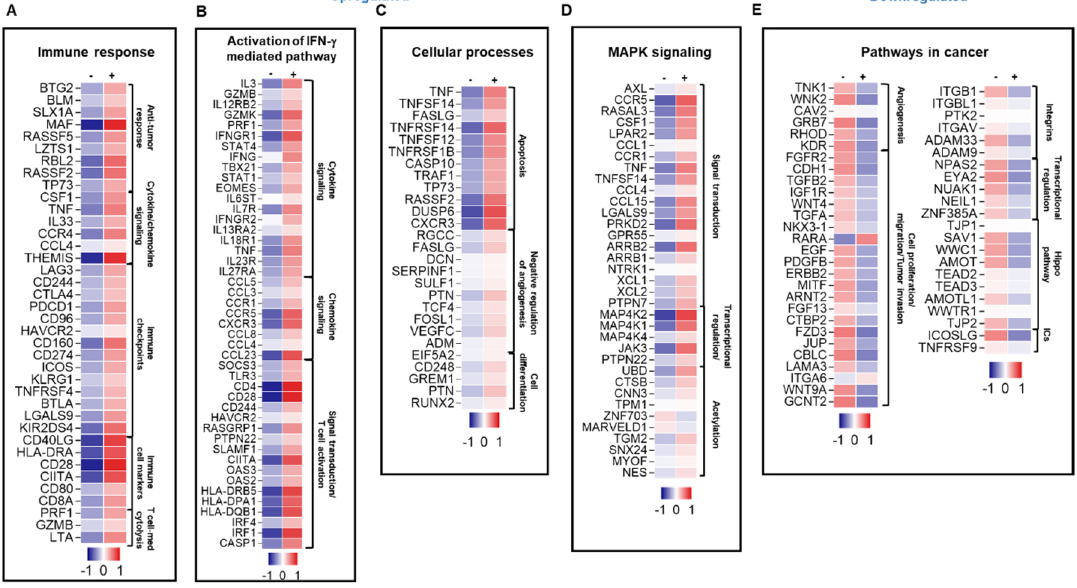
Figure 3. Differential gene expression of breast tumor-infiltrating immune cells in response to atezolizumab treatment. Heatmaps show the Z-score calculated from the TPM of each gene to compare the expression level in tumor-infiltrating immune cells treated with anti-PD-L1 vs. non-treated cells. Each column represents a sample pooled from two explant cultures either treated or untreated, and each row represents the Z-score for mean expression obtained from two explant cultures (patients #57 and 59). The Z-score for the mean expression level of each gene is depicted according to color scale. The functional categorization of top significantly upregulated and downregulated genes (with a fold change of >2 and p value <0.05 cutoffs) from CLC analysis were separately analyzed through the DAVID platform. Genes involved in immune response ( A ), the activation of the IFN- γ -mediated signaling pathway ( B ), cellular processes ( C ), and MAPK signaling ( D ) were upregulated in response to anti-PD-L1, while genes in cancer-related pathways ( E ) were downregulated. and tumor cell survival / migration / invasion (CDH1, RARA, WNK2, WNT4A, WNT9A, TGFB2,